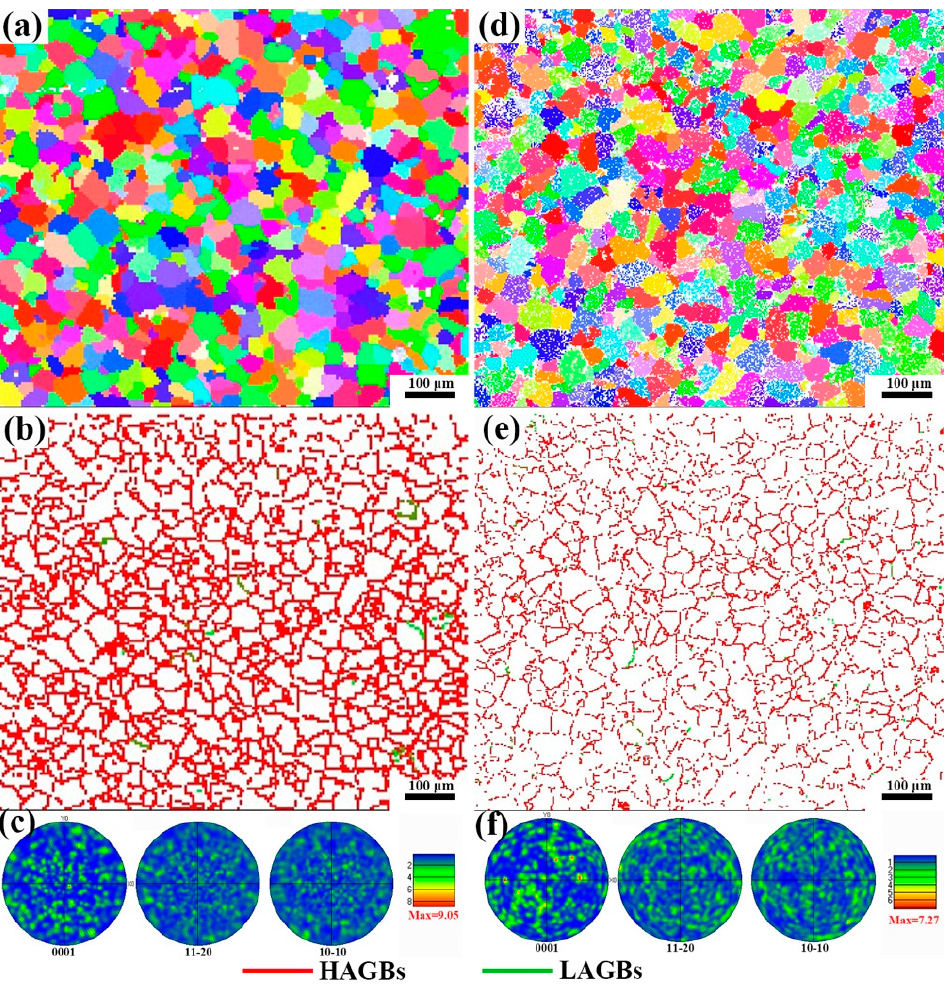
Figure 7. IPF image, grain boundary image and pole figure of as-cast alloy ( a – c ) and alloy after solution treatment for 12 h ( d – f ).